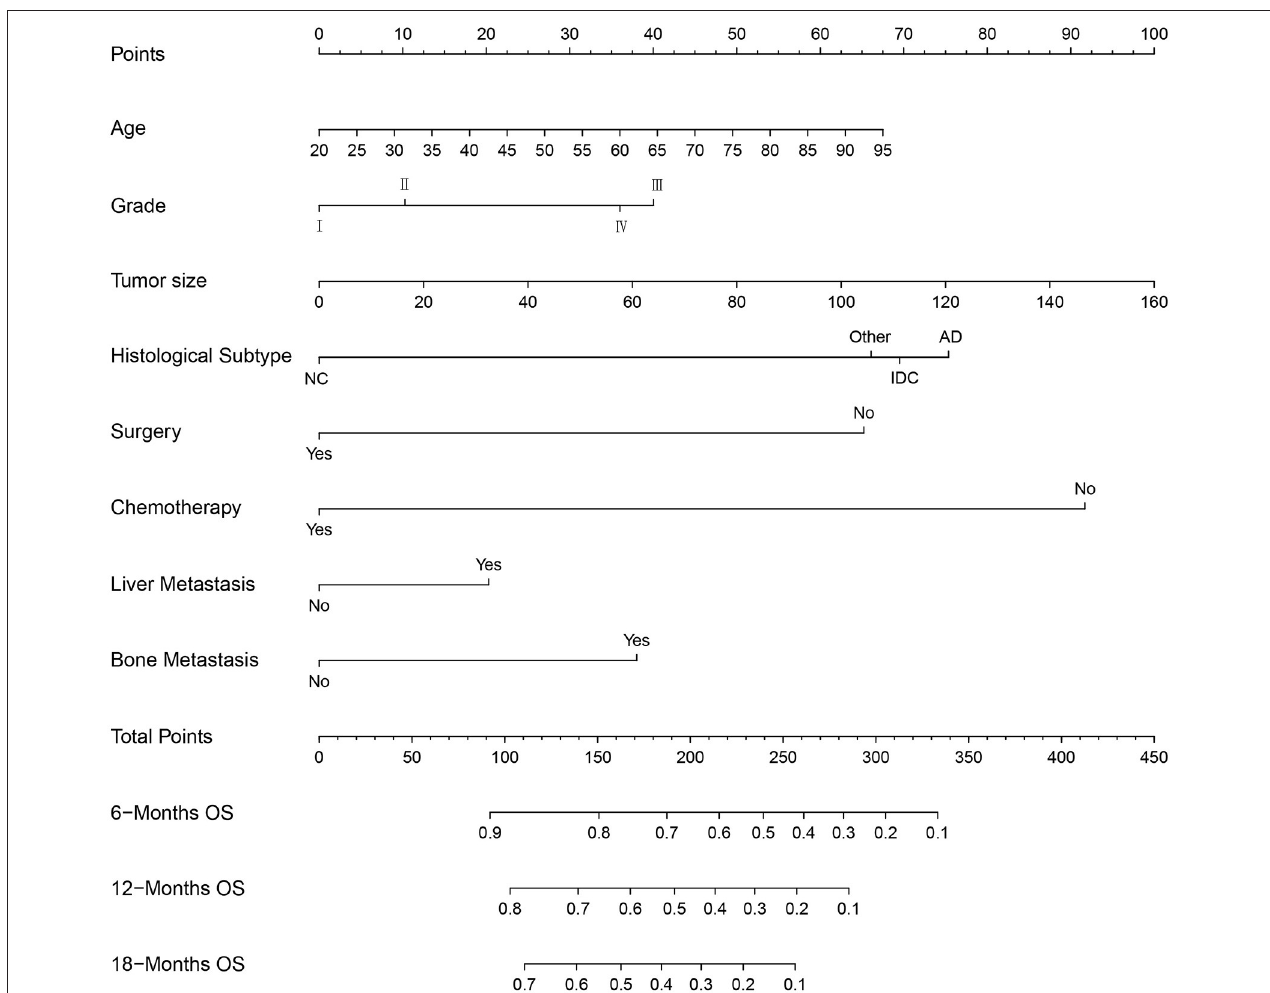
FIGURE 6 | Nomogram for predicting the overall survival of patients with pancreatic cancer presenting with lung metastasis. To use this nomogram, the specific point for each variable of the patient lies on each variable axis. Draw a vertical line upward to determine the point at which each variable accepts; the sum of these points is located on the Total Points axis, and draw a vertical line down to the survival axis to determine the probability of 6-, 12- and 18- months overall